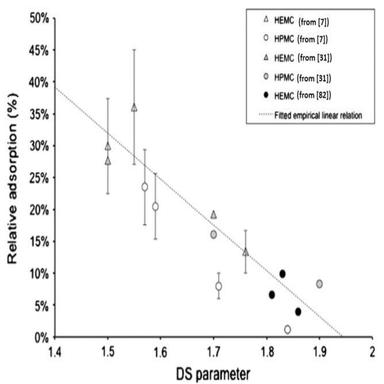
Relative CE adsorption as a function of the DS for a CE dosage of 0.2% that it is below the overlapping concentration. Reproduced from with permission.